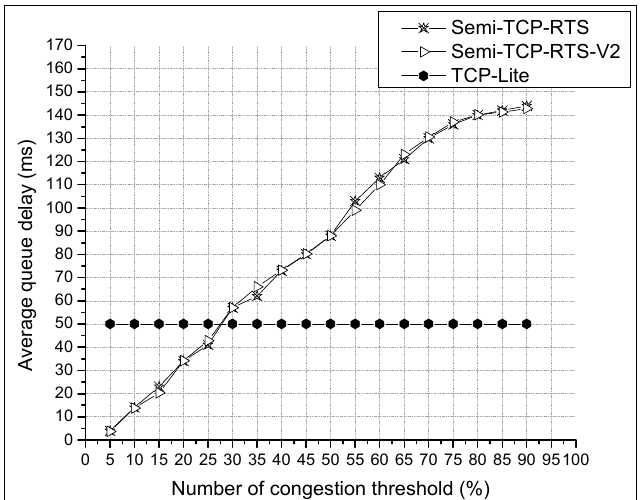
Figure 9. Average queue delay with various CTh settings of node J.